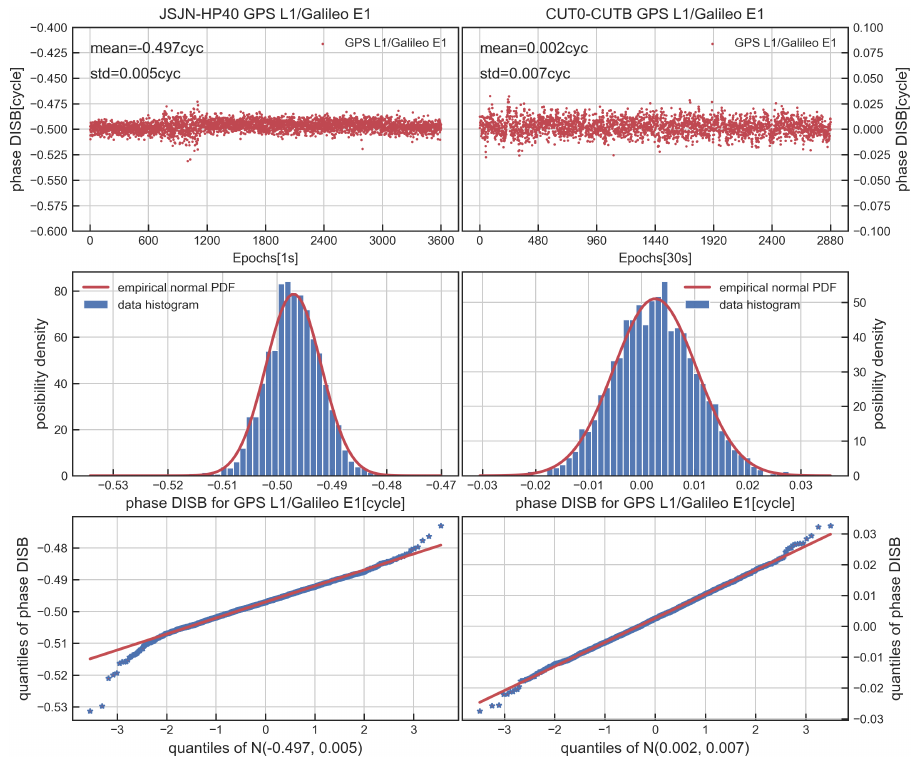
Figure 6. Time series, distribution and QQ plot of GPS L1/Galileo E1 phase DISB for JSJN − HP40 ( left ) and CUT0 − CUTB ( right ).